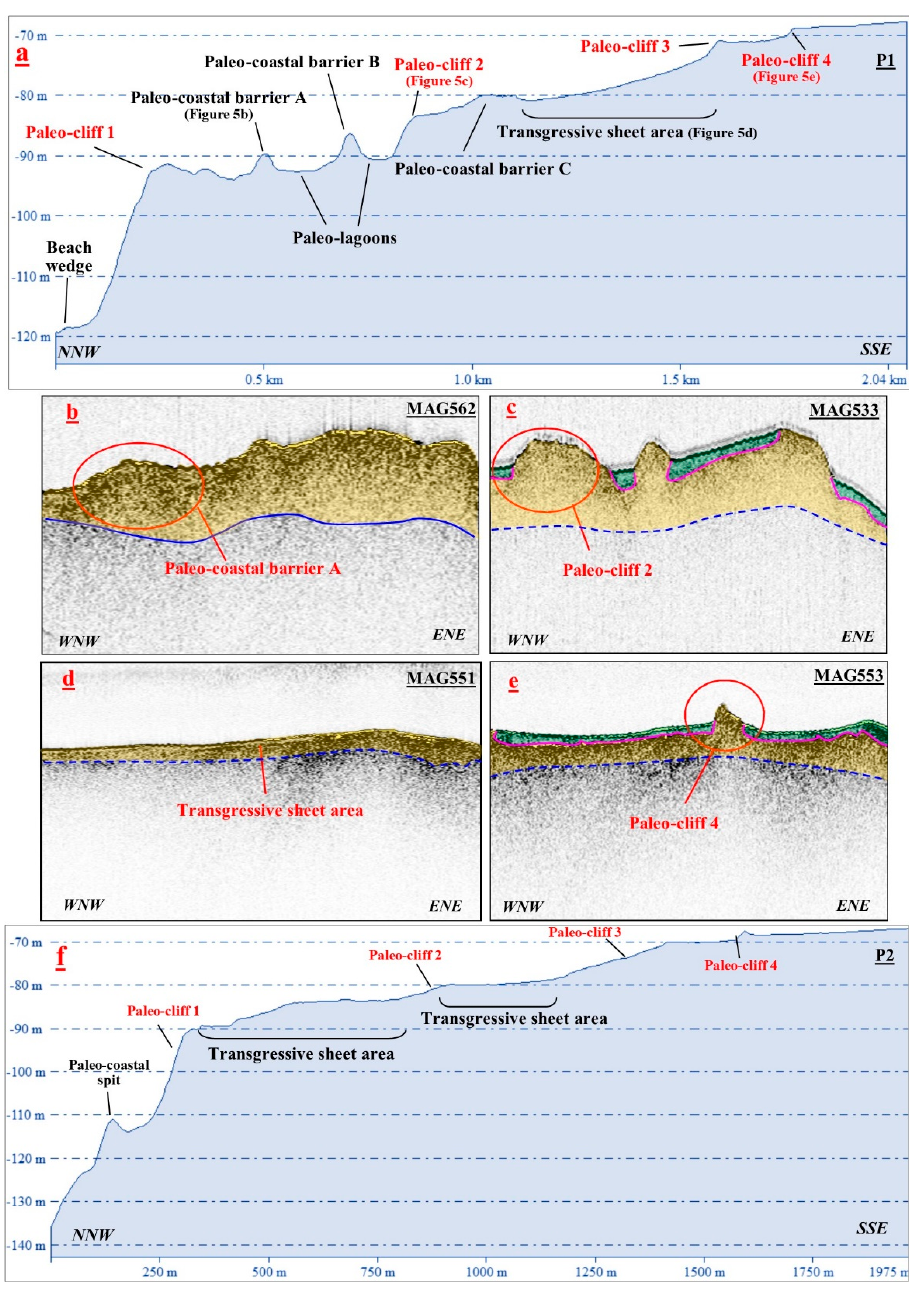
Figure 5 . ( a ) The P1 bathymetric profiles arranged in NW-SE direction and location of the main TST geomorphic elements. ( b ) Detail of the profile MAG562. ( c ) Detail of the profile MAG533. ( d ) Detail of the profile MAG551. ( e ) Detail of the profile MAG553. ( f ) The P2 bathymetric profiles arranged in NW-SE direction and location of the main TST geomorphic elements.